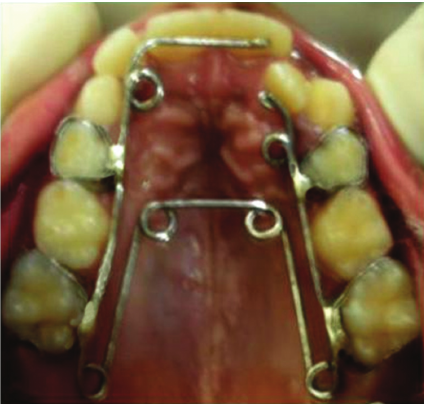
Figure 3: Activated hexa helix appliance.